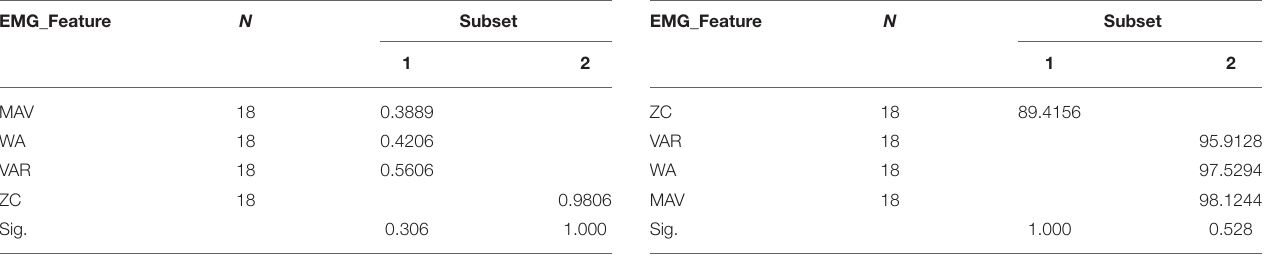
TABLE 14 | The results of the Tukey HSD for MAVE.